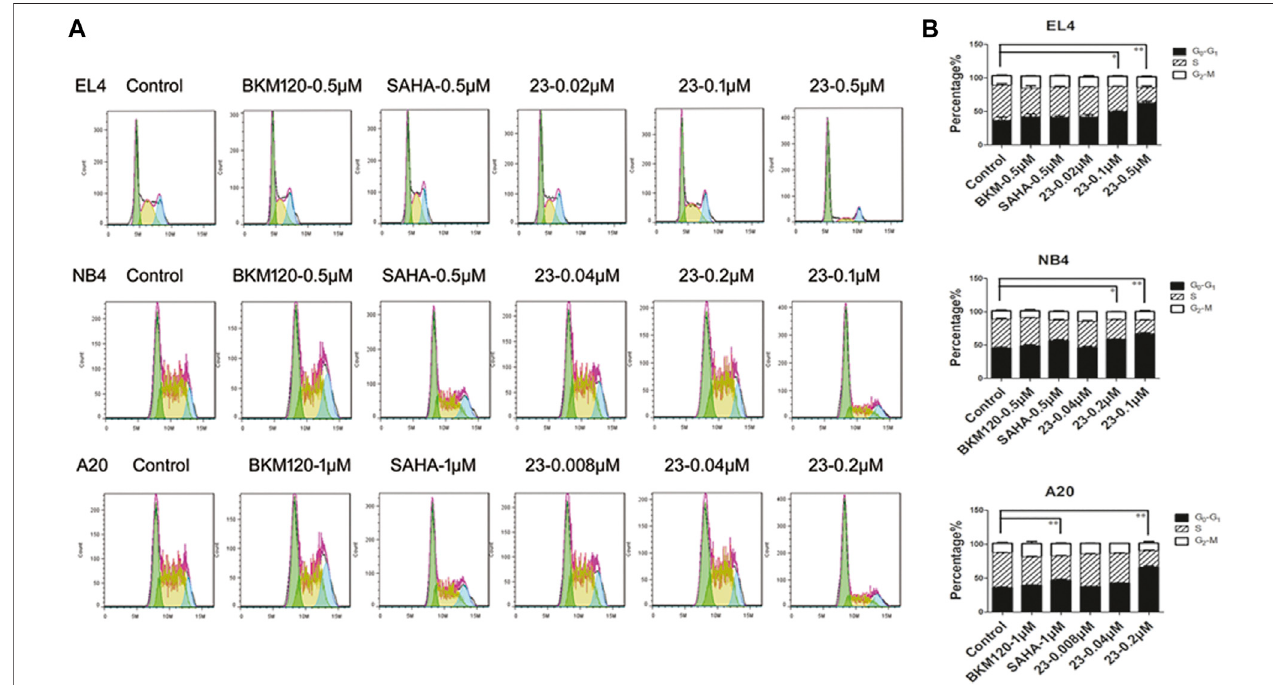
FIGURE4| Compound 23 inducedG1-phasecell cyclearrest. EL4, NB4,and A20cells weretreatedwith dimethyl sulfoxide (DMSO), SAHA , BKM120 , orDMSO with increasing concentrations of 23 for 24 h. Flow cytometry analysis of propidium iodide (PI) staining was used to assess cell cycle distribution. (A) Representative histograms of cell cycle distribution analyzed by PI staining. (B) Bar columns showing relative percentages of cells in S, G1, and G2 phases of the cell cycle following treatment with compound 23 or reference compounds (* p < 0.05, ** p < 0.01, *** p < 0.001 vs